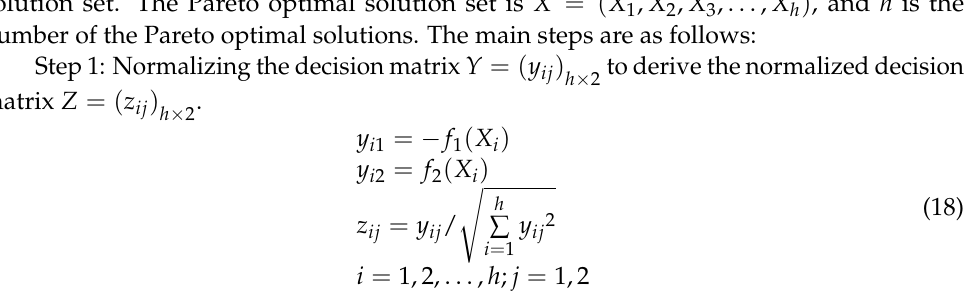
Figure 5. The execution on step of elitist strategy.